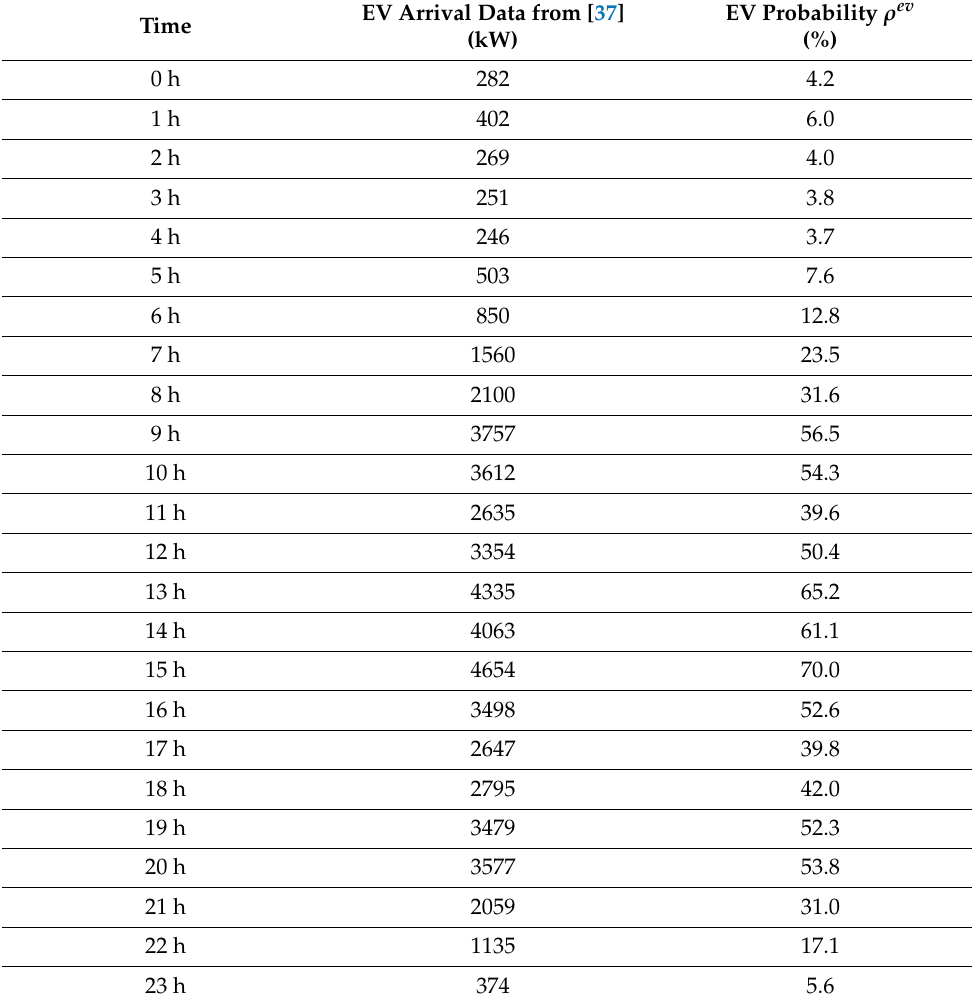
Table 2. Day-ahead EV arrival forecast based on the results of